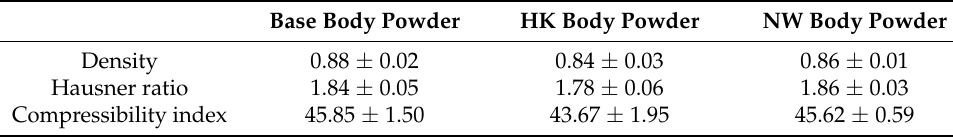
Figure 9. Appearance of compact powder ( a ) base compact powder ( b ) containing M. acuminata (AAA) ( c ) containing M. sapientum L. (ABB). Table 3. The flow properties of the body powder containing 15%